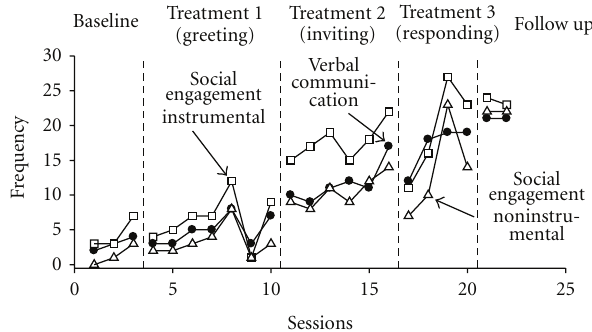
Figure 3: Concomitant behavior changes pre-, during and postin-